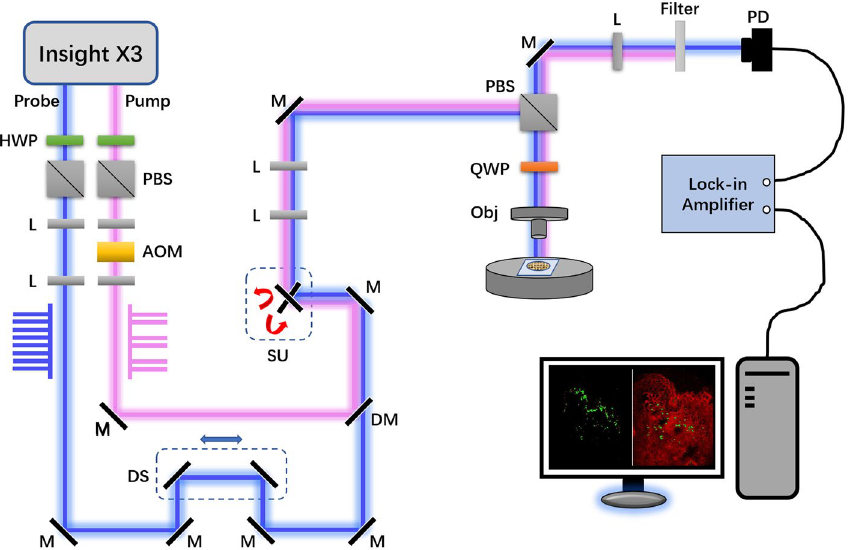
Figure 1. Schematic design of pump-probe imaging system. HWP half-wave plate, PBS polarizing beam splitter, L lens, AOM acousto-optic modulator, M mirror, DS delay stage, DM dichroic mirror, SU scanning unit, QWP quarter-wave plate, Obj objective, PD photodiode.